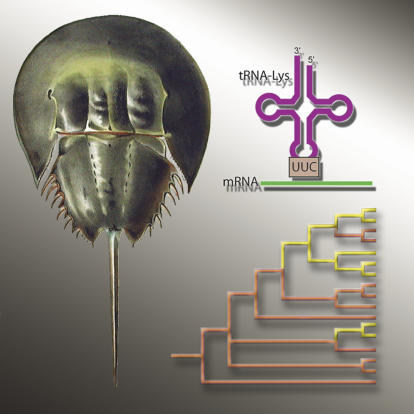
The horseshoe crab uses the newly discovered genetic code (AGG translates into lysine rather than serine). Parallel evolution of this and the typical code of invertebrate mitochondrial genomes (which is correlated with tRNA mutations) occurred repeatedly along the evolutionary history of arthropods. (Figure: horseshoe crab lithograph by George Endicott)